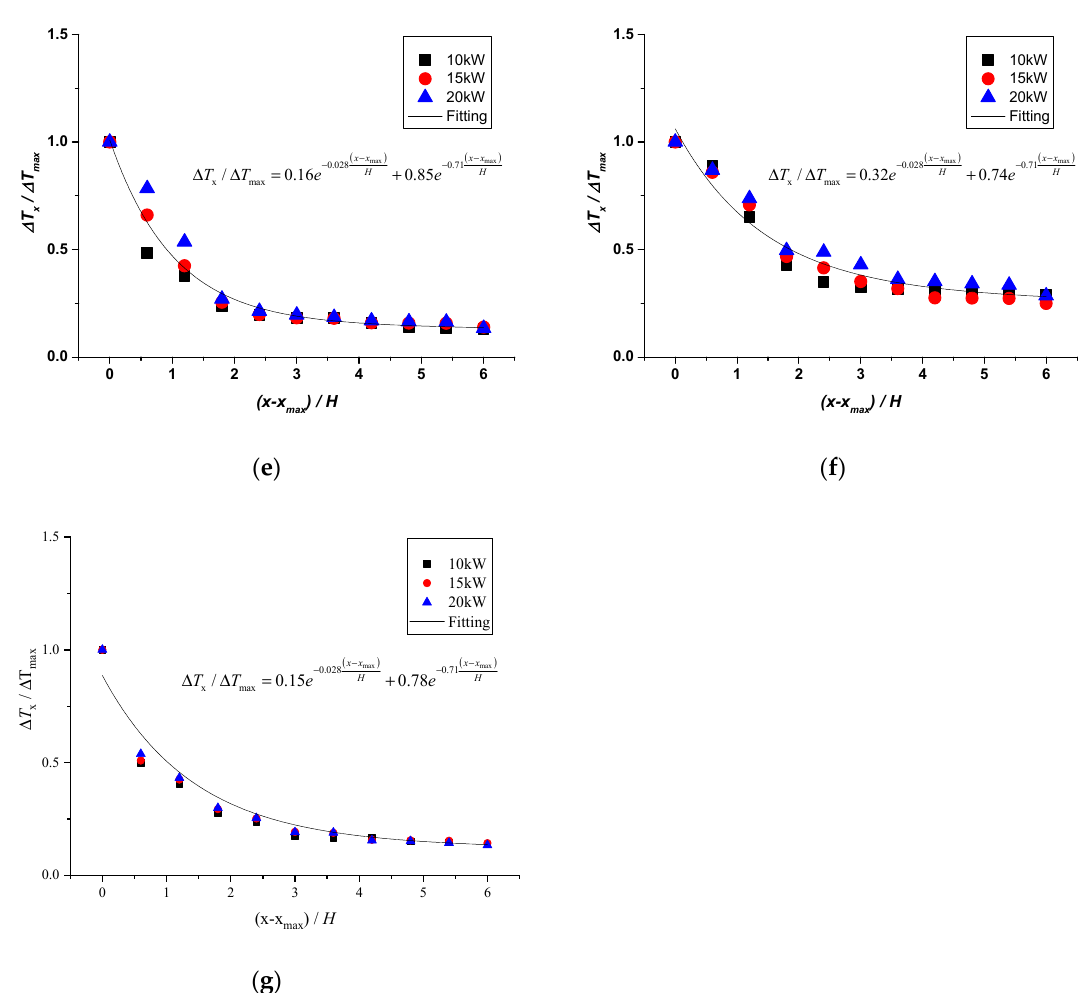
Figure 12. Ceiling temperature distribution relative to distance with a dam-board at the corridor end: ( a ) 0 m/s; ( b ) 0.2 m/s; ( c ) 0.5 m/s; ( d ) 0.85 m/s; ( e ) 1.24 m/s; ( f ) 1.52 m/s; ( g ) 1.85 m/s.